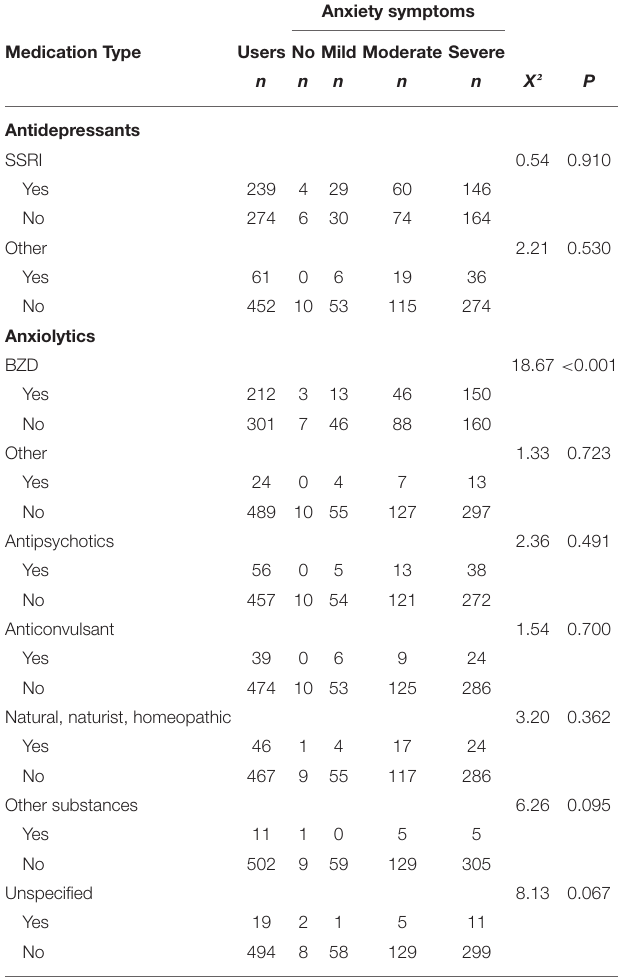
TABLE 5 | Medication use and types and their relationship to anxiety. Anxiety